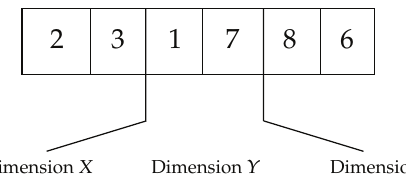
Figure 8: State array and dimensions.